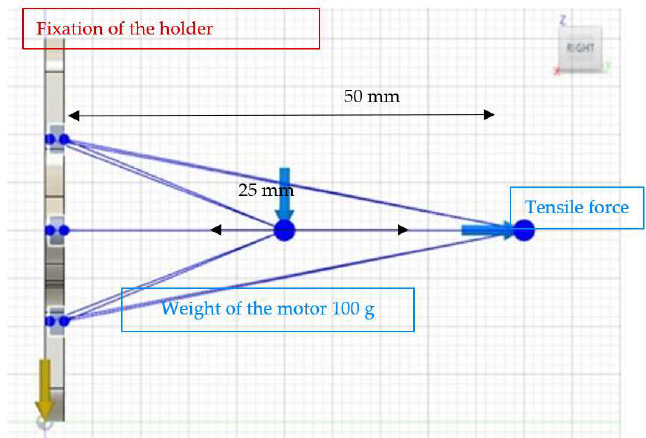
Figure 10. Parameters of the